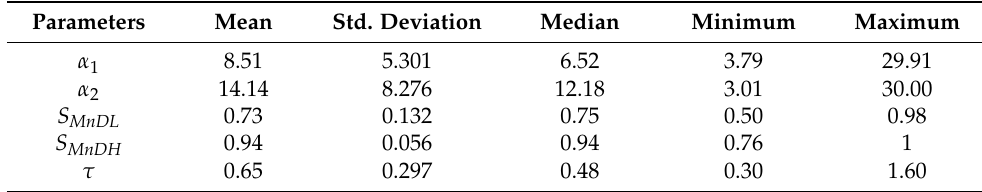
Table 1. Statistic results of DBCs.